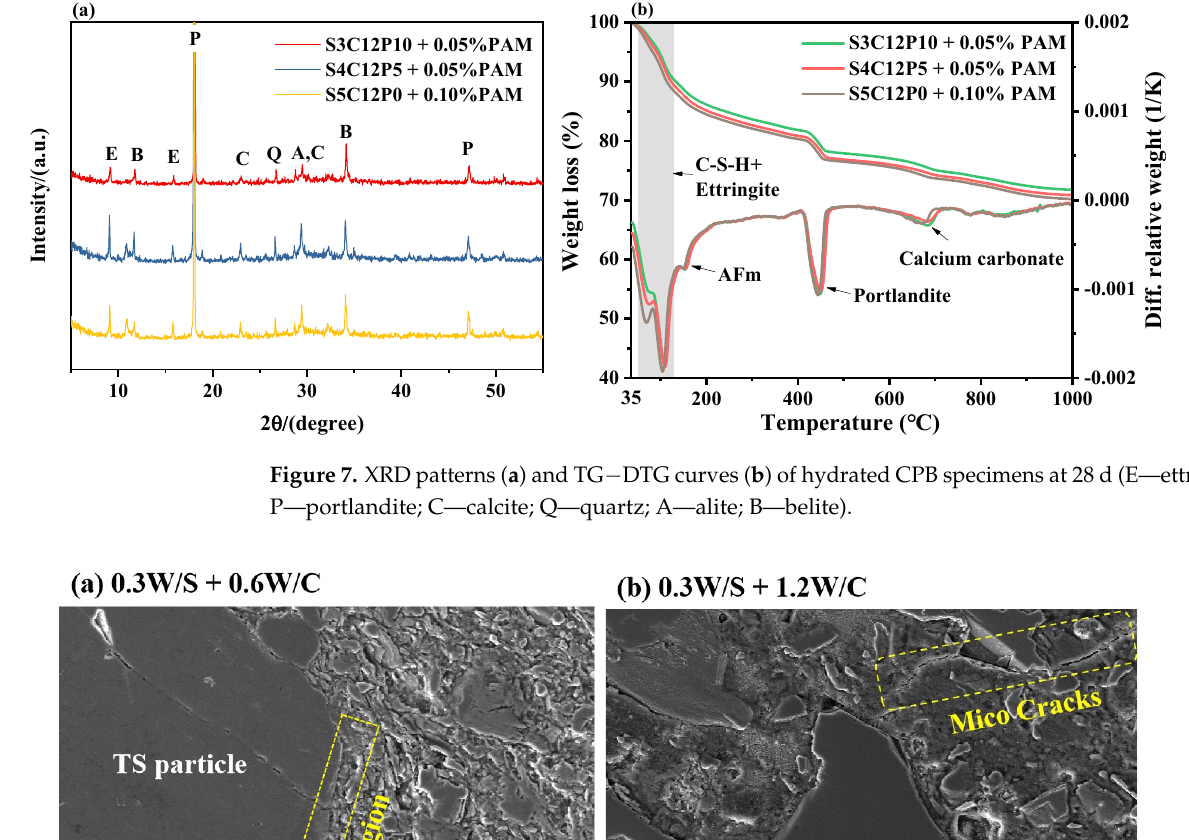
Figure 6. Microstructural features of CPB specimens at 28 d.